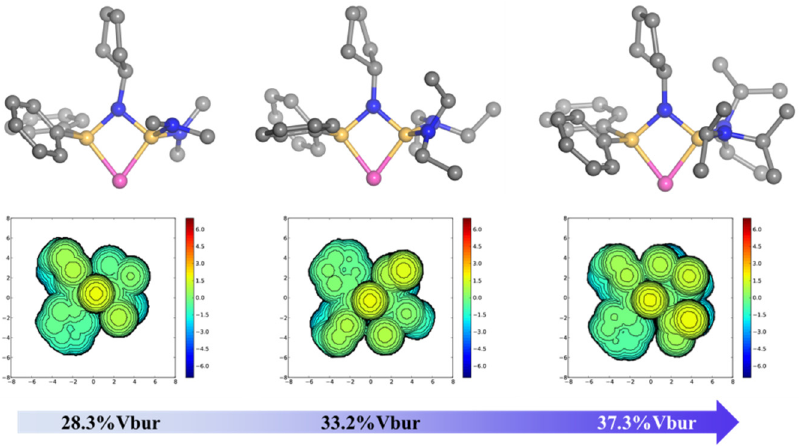
Figure 1. Structures of steric maps for precatalysts 1 – 3